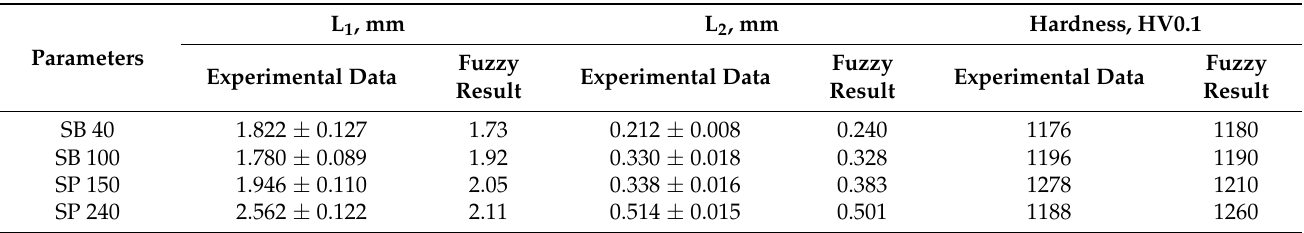
Table 6. Values of geometry and hardness from the fuzzy system and experimental